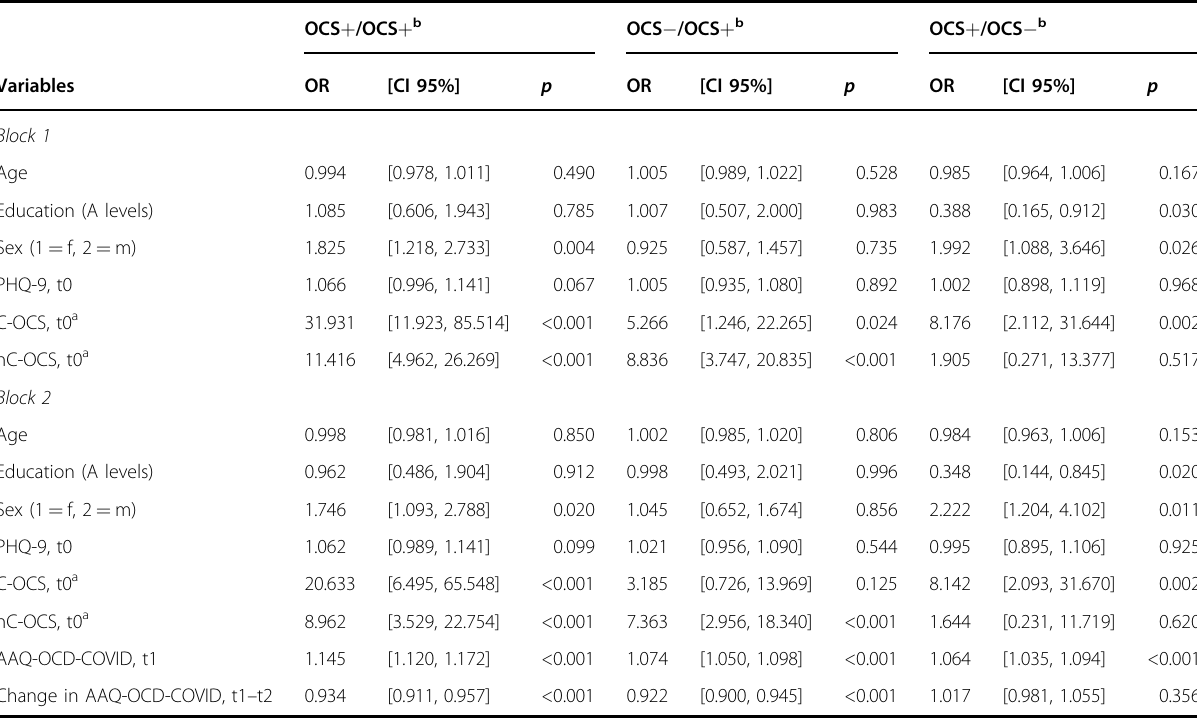
Table 2 Association of the factors with group membership ( n = 1207): hierarchical multinomial regression.